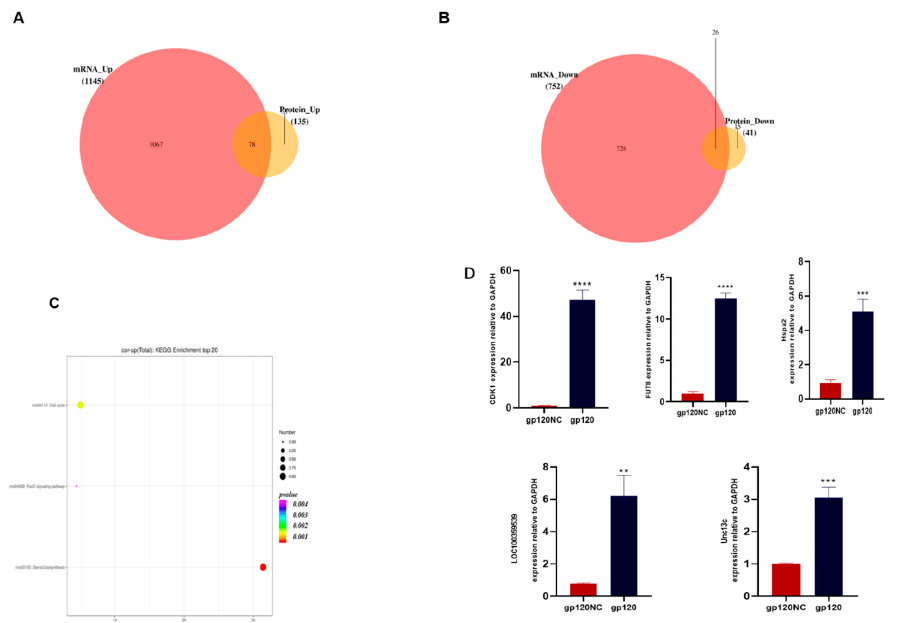
Figure 5. Venn diagrams showing overlaps between genes upregulated transcriptomics and pro- teomic analyses data sets analyses for pc12 cell lines expressing gp120. ( A ) The overlap between genes upregulated in transcriptomics and proteomics ( B ) The overlap between genes downregulated in transcriptomics and proteomics data sets. ( C ) KEGG enrichment analysis of top 20 upregulated can- didate genes with their respective pathways. Low q-values are highlighted in red, while high q- values are highlighted in blue to purple; the size of the circle is proportional to the number of en- riched genes. Candidate genes are those genes overlapped between in transcriptomics and prote- omics. ( D ) Significant upregulation of candidate genes in PC12 by gp120 in qPCR, n = 3. t -test ** p < 0.01, *** p < 0.001, **** p < 0.0001.